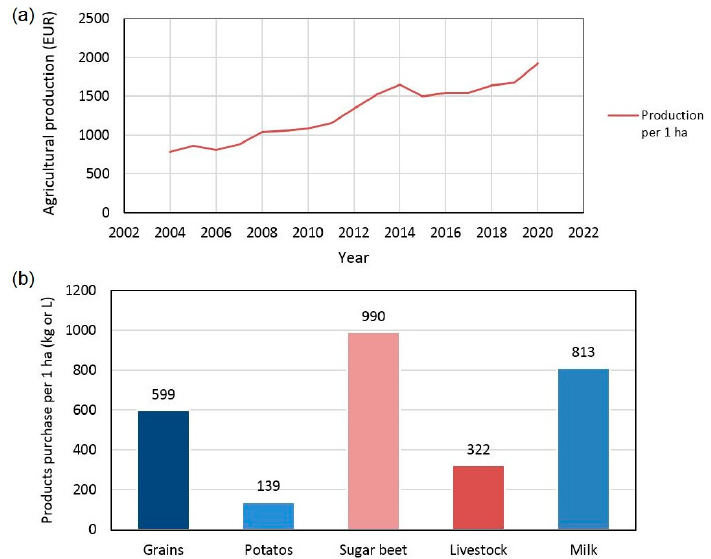
Figure 26. Agricultural productivity in Poland, data obtained from [66]: ( a ) agricultural production purchase value per 1 hectare in 2004–2021, ( b ) agricultural products purchase per 1 ha structure in 2021.